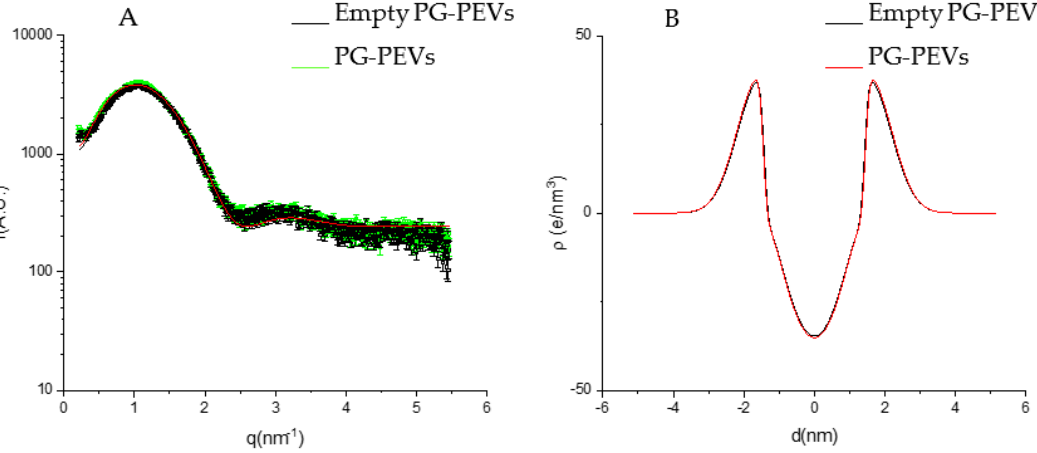
Figure 3. ( A ) SAXS profiles of empty and P. spinosa loaded liposomes. The lines correspond to the best fit of Gaussian bilayer models. ( B ) Electron density profiles corresponding to the best fits of empty and P. spinosa loaded liposomes. empty and P. spinosa loaded liposomes.